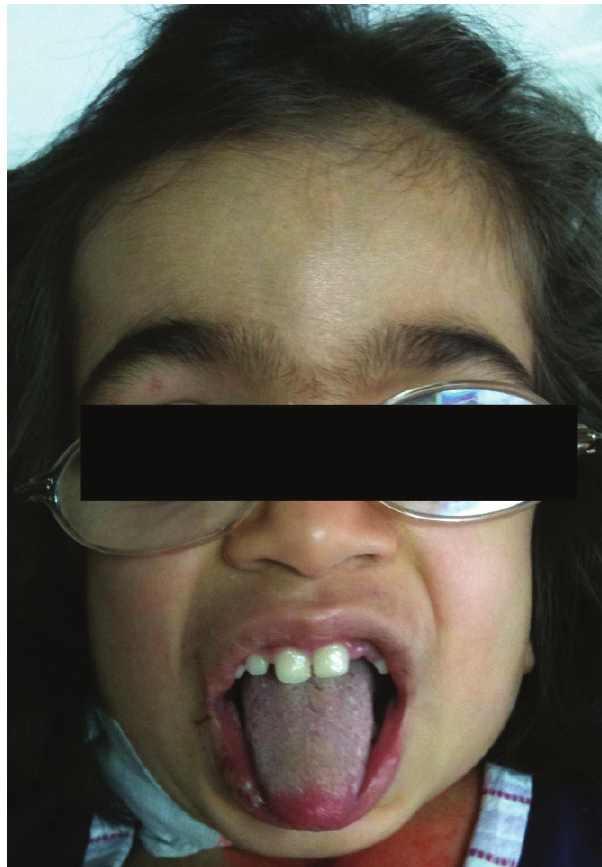
Figure 2 - Coarse face - one of the confirmatory feature of